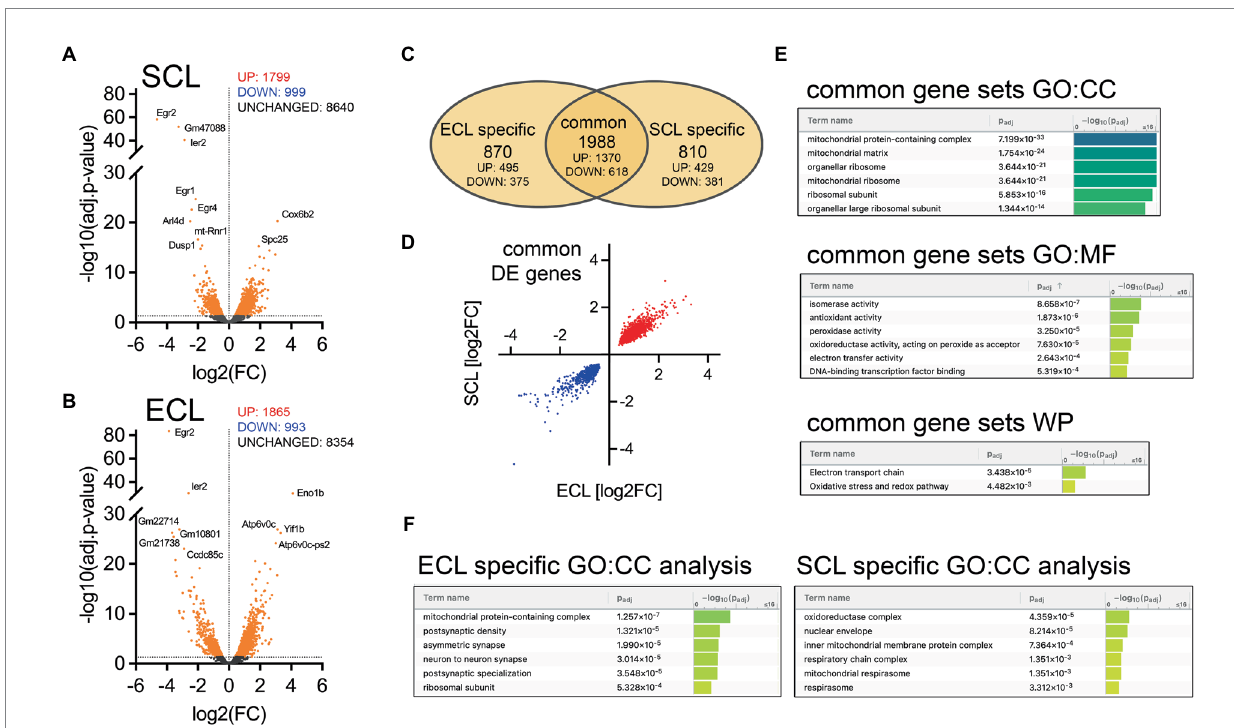
FIGURE 4 Lesion leads to pathway-specific transcriptomic changes in the hippocampal CA1 region. (A) Volcano plot illustrating differential gene expression in the CA1 region of non-lesioned cultures vs. 3 days following SCL (n control = 5 cultures, n SCL = 4 cultures). The significance threshold [ p adj. < − log10(0.05)] is indicated by a dashed line. Significantly regulated genes are marked in orange and the top-10 regulated genes are labeled. (B) Volcano plot illustrating differential gene expression in the CA1 region of control cultures vs. 3 days following ECL (n control = 5 cultures, n ECL = 4 cultures). The significance threshold [ p adj. < − log10(0.05)] is indicated by a dashed line. Significantly regulated genes are marked in orange and the top-10 regulated genes are labeled. (C) VENN-diagram to illustrate commonalities and differences in ECL-and SCL-induced differential gene expression. Although a